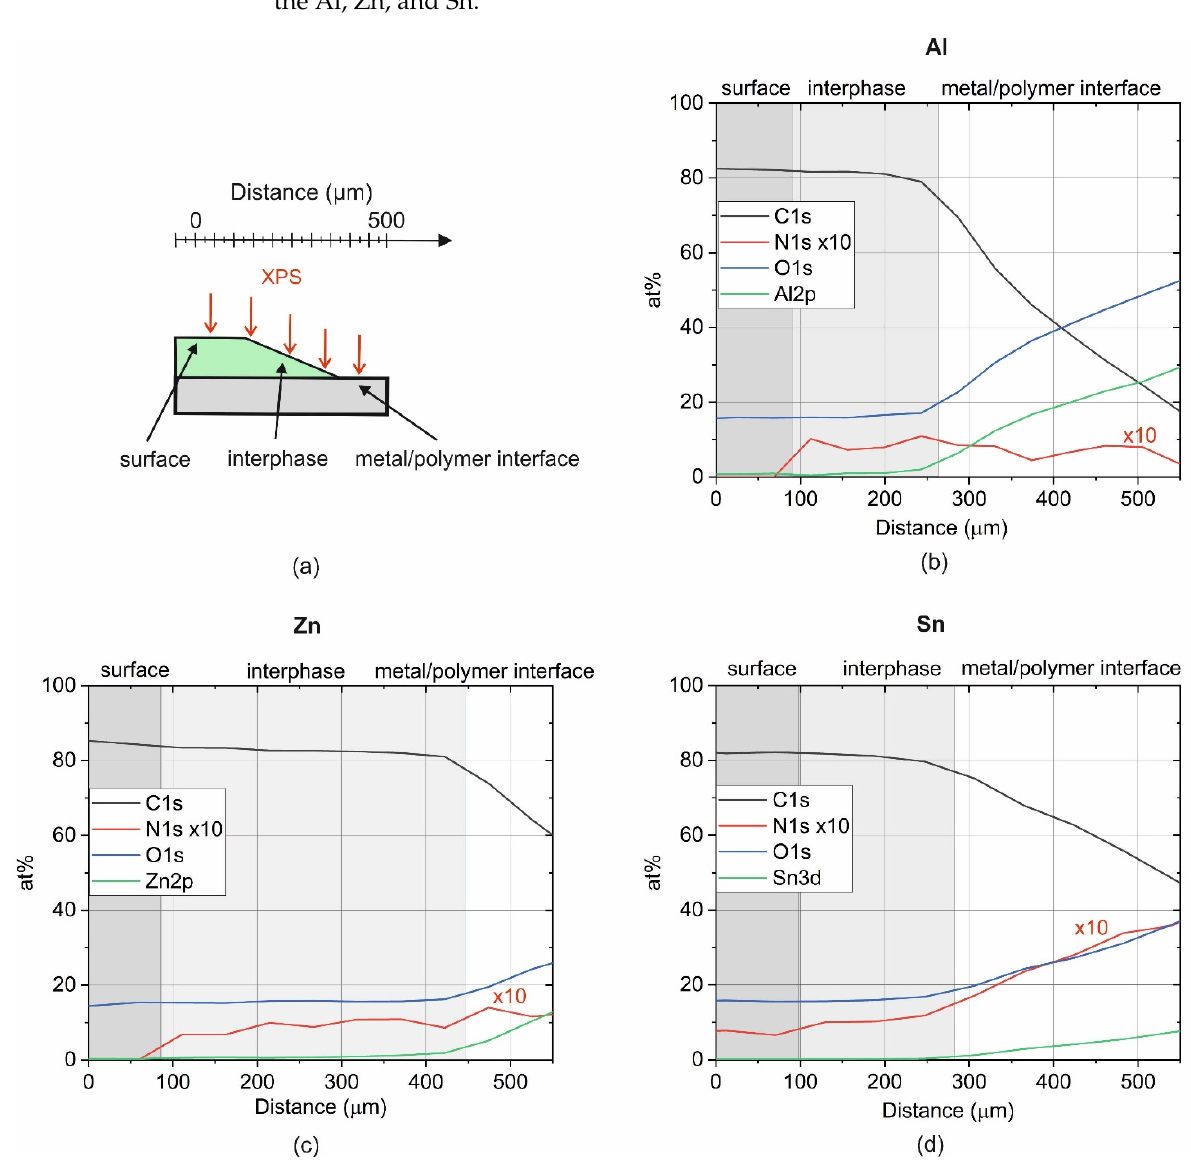
Figure 7. In ( a ), the schematic of an ULAM cut is depicted, along which XPS linescans have been performed, with ( b ) Al, ( c ) Zn, and ( d ) Sn as the substrate materials, respectively. The signal of N is multiplied by a factor of 10 in all graphs for better visibility. The light grey area labeled “interphase” represents the uncovered part of the coating with a thickness of 5 µ